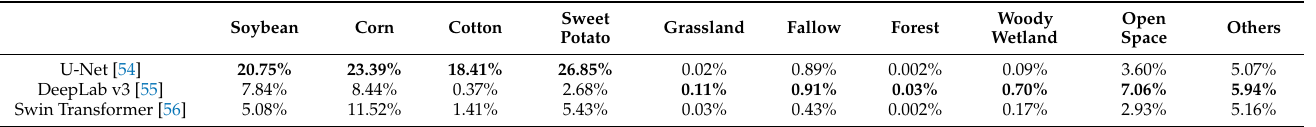
Table 4. The proportion of “non-rice misidentification” for each land use type.